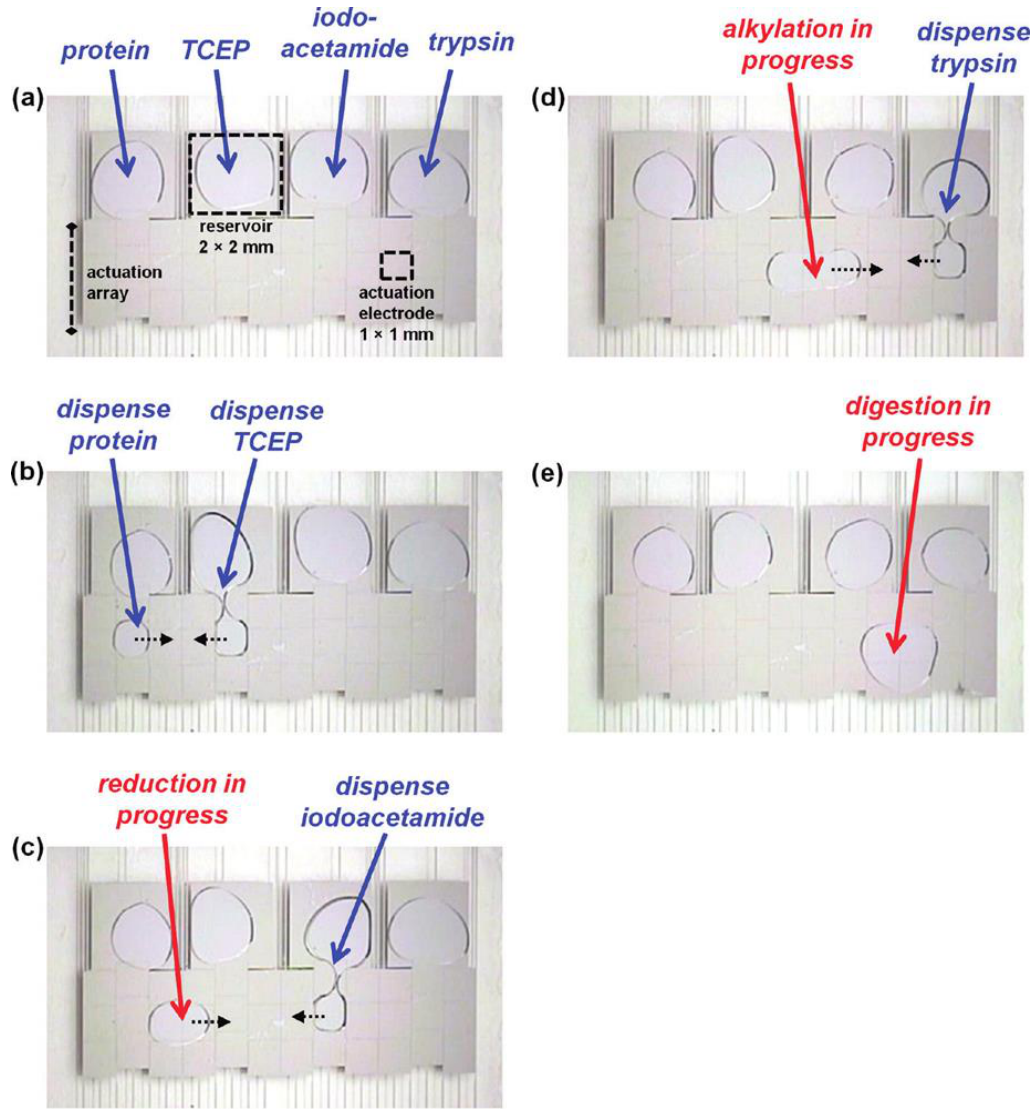
Figure 7. Protein analysis illustrated using a two-plate EWOD DMF chip (reproduced with permission from [66]); ( a ) pre-loaded samples/reagents on the proteomic chip; ( b , c ) protein reduction using tris-(2-carboxyethyl)phosphine (TCEP); ( d ) protein alkylation using iodoacetamide; and ( e ) the digestion step using